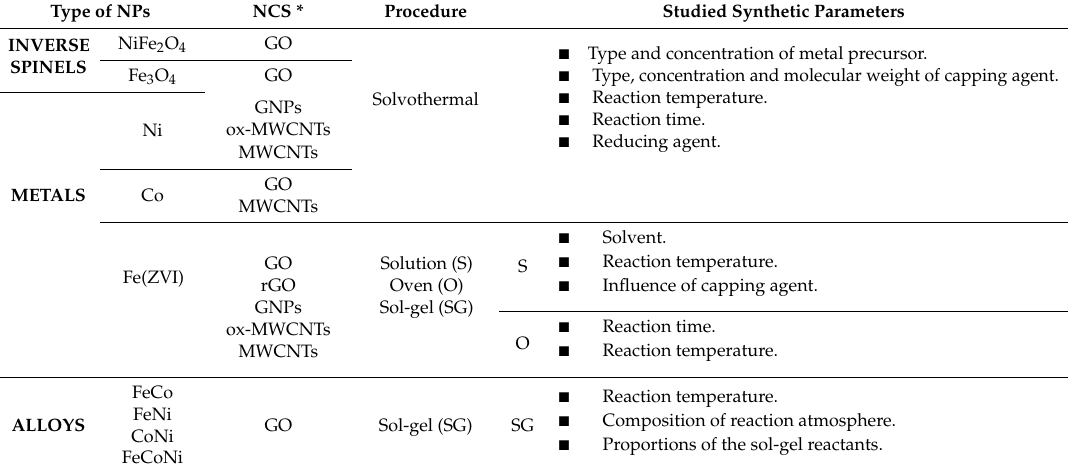
Table 2. Summary of the studied synthetic procedures and resulting MNPs@NCS nanocomposites. Type of